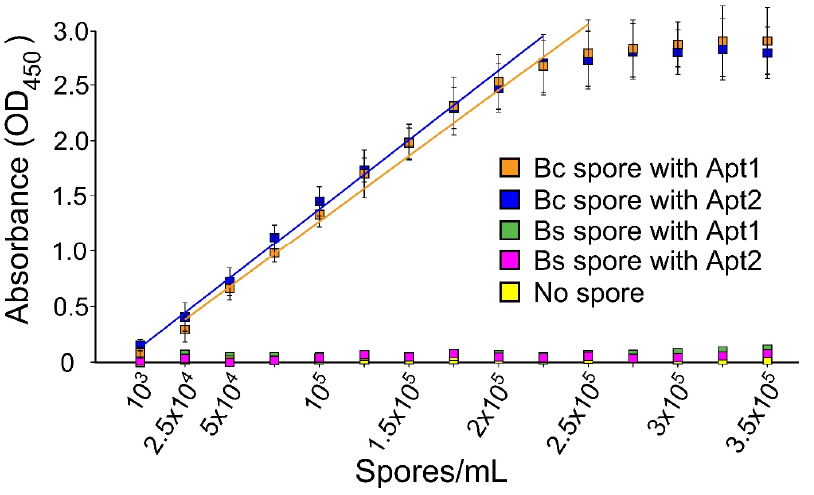
Figure 4. Range of detection of aptamers using ELISA . Detection with Apt1 and Apt2. This experiment was repeated thrice. Error bars represent standard deviations. Trend lines are shown to highlight the linear range of detection. Abbreviations: Bc, Bacillus cereus ; Bs, Bacillus subtilis . Apt3 also detected B. cereus spores at a similar range as Apt1, but Figure 3C shows that it also non-specifically bound reaction to B. subtilis spores (Figure 4). The low cross- reaction signal from increasing concentrations of B. subtilis is also illustrated in Figure 5.